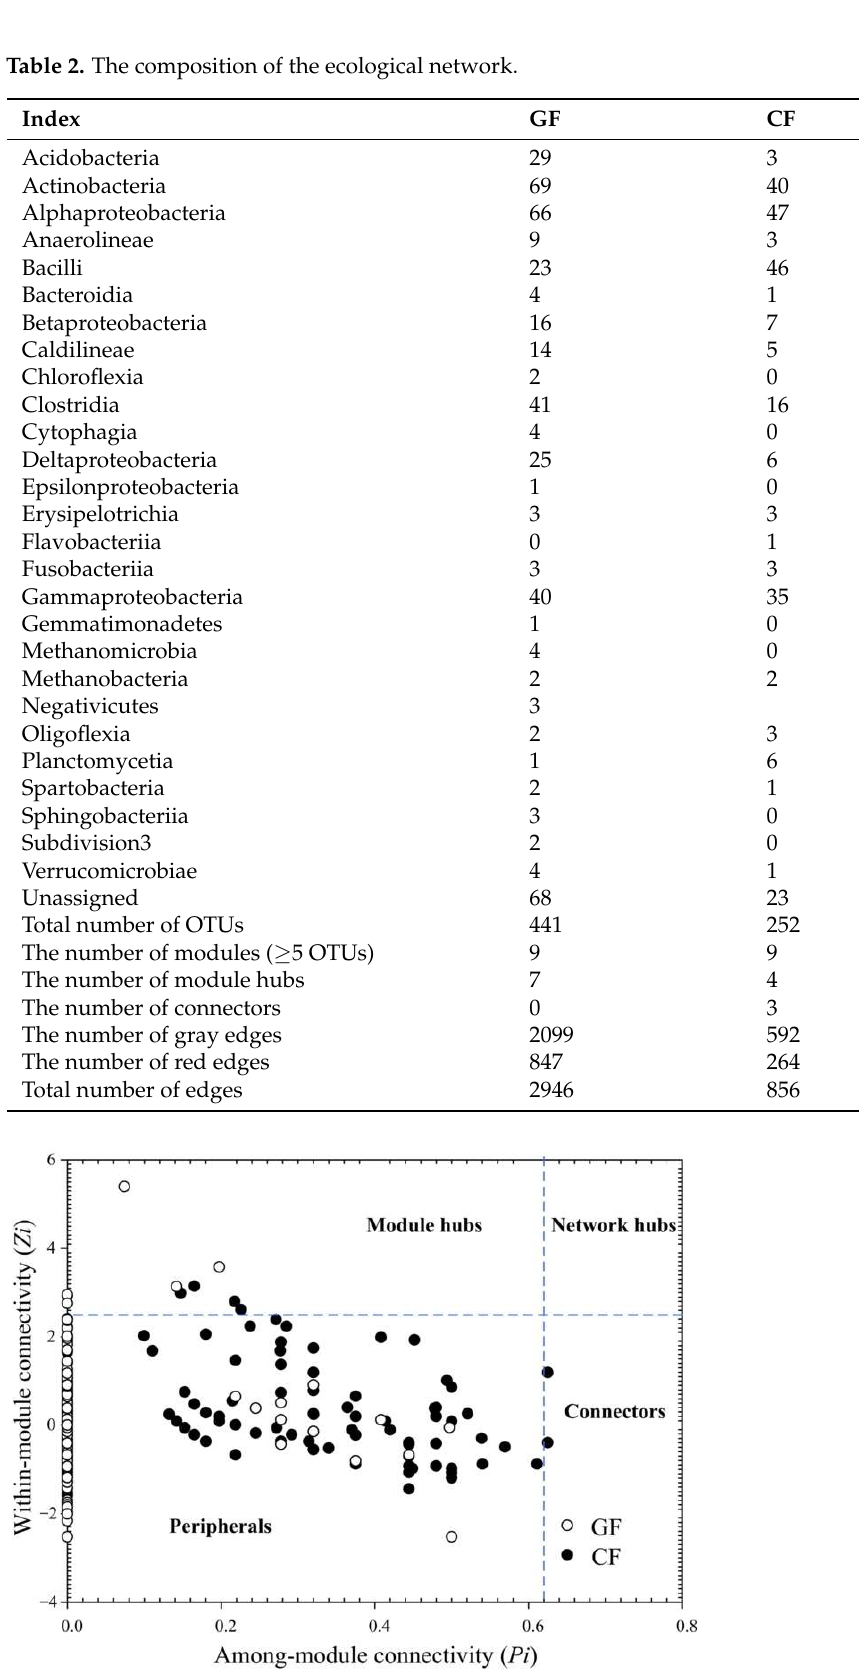
Figure 6. Z-P plot showing the distribution of OTUs based on their topological roles.